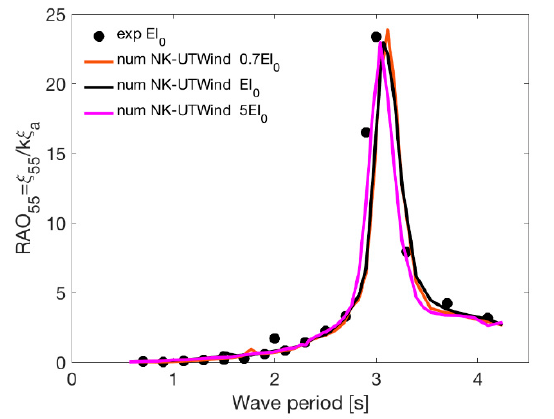
Figure 19. RAO pitch motion result comparisons between the experiment and NK-UTWind numerical calculations for different structural rigidities.